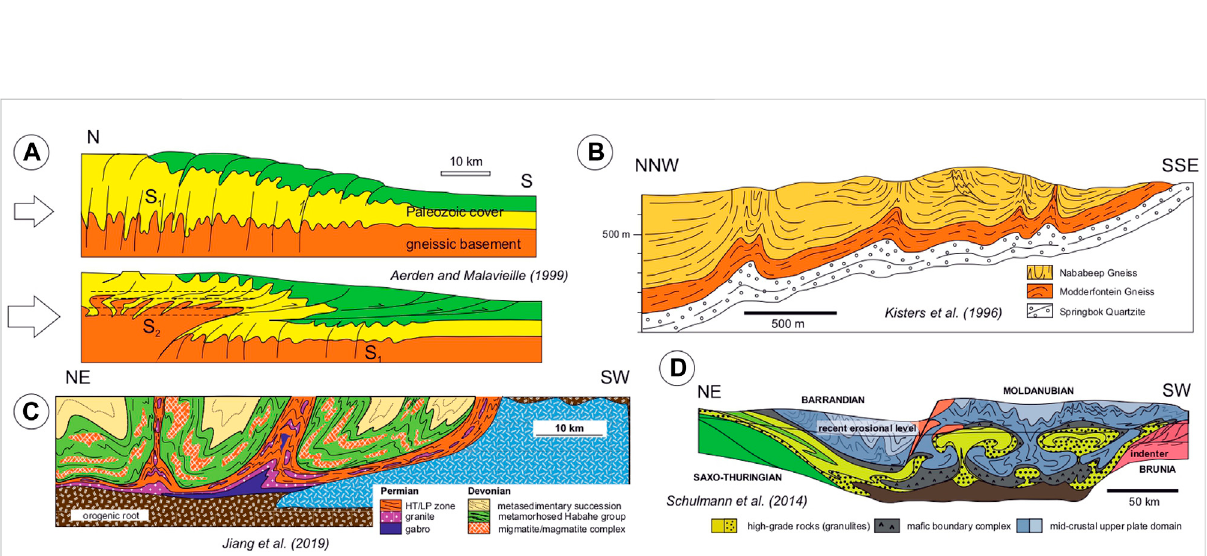
FIGURE 9 Sections through orogens with comparable folding styles to analogue models in this study. All fi gures are redrawn and simplifed from the original publications. (A) Regular short wave-length folding in the fi rst stage of the Variscan Montagne Noire corresponds to homogeneous thickeningStyle2inFigure8.Hightemperaturemetamorphicconditionsculminatedinwidespreadmigmatizationofthebasementduring upliftand decompression.Developmentofthenappeisassociatedwithgravitationallyinducedspreadingoftheorogen(AerdenandMalavieille,1999). (B) Cusp-like folds in the anatectic granite-gneiss sequence folded during granulite facies metamorphism (Kisters et al., 1996), corresponds to Style 1 (Figure 8). (C) In the Chinese Altai, anatectic high-temperature lower crustal rocks with vertical fabrics alternate with metamorphosed metasediments in synclines (similar to Style 4, Figure 8; after Jiang et al., 2019). (D) A section through Bohemian Massif with diapiric fold-like protrusions of the partially molten relaminated lower plate felsic crust into the middle crustal metamorphic rocks of the upper plate (Moldanubian andTeplá-Barrandian;Schulmannetal.,2014).Thisorogenislinkedtothe ‘ veryhot ’ Style5(Figure8).All fi guresareredrawn/modi fi fedafteroriginals from the cited